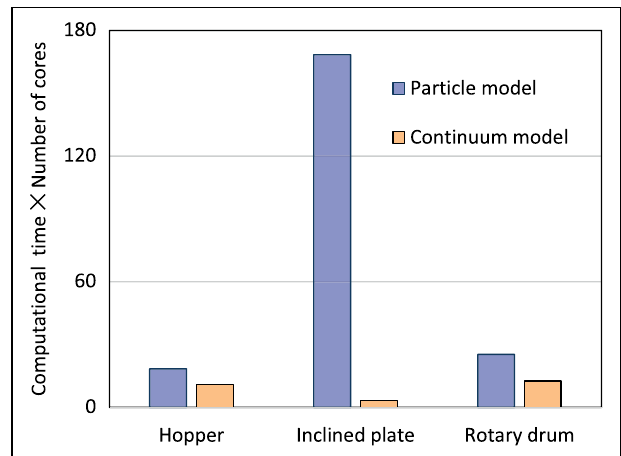
FIGURE 9 | Comparison on the computational cost between the continuum FEM model and the particle DEM model for the hopper flow simulation ( θ = 30 o , W = 60 mm and physical time t = 11s), the inclined plate simulation ( η = 29.5 o , t = 18.8 s ), and the rotary drum simulation ( ω = 20 rpm, t = 10 s